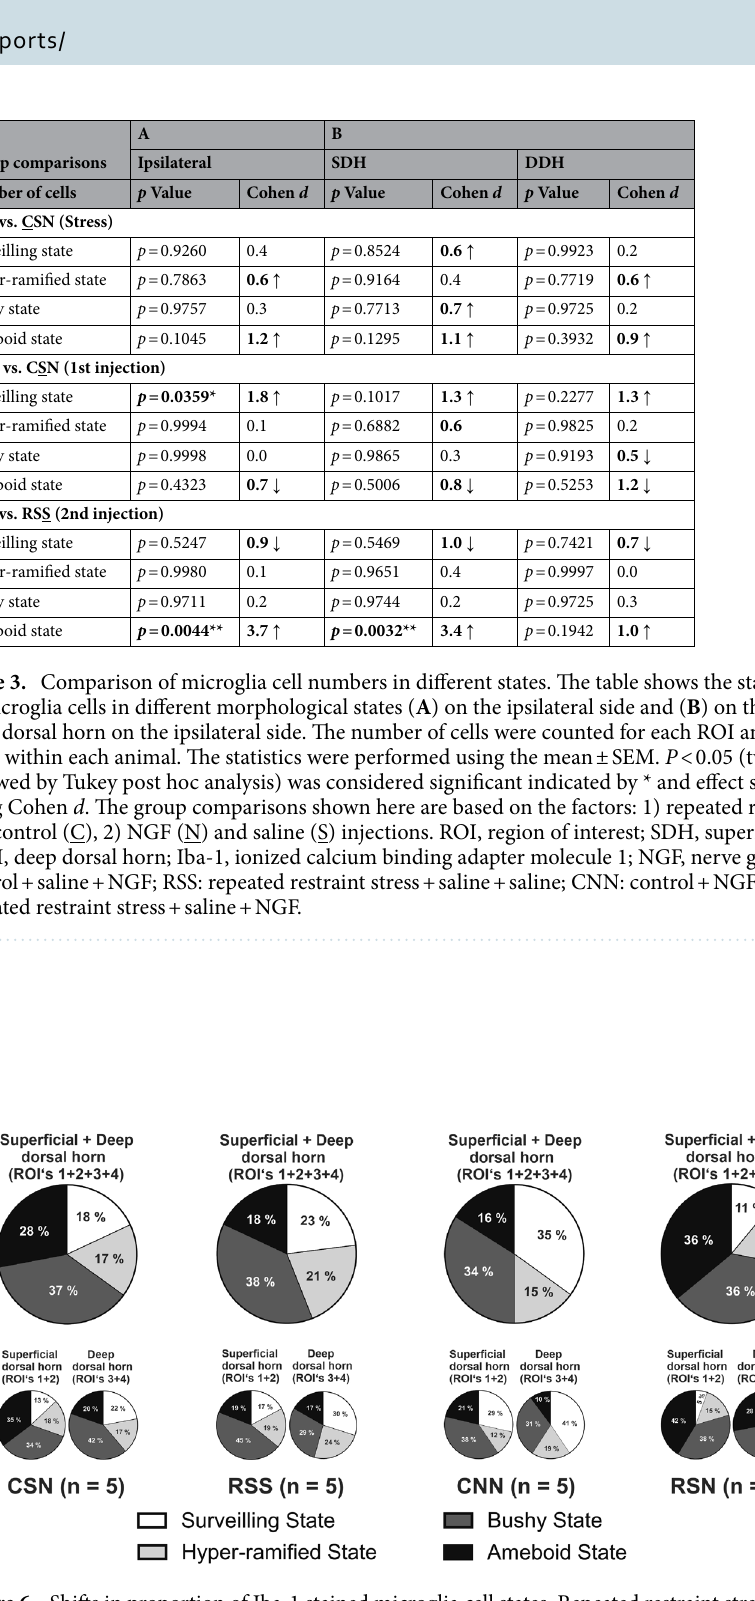
Figure 6. Shifts in proportion of Iba-1 stained microglia cell states. Repeated restraint stress in adolescence and intramuscular NGF in adulthood leads to increased ameboid state microglia cells in the ipsilateral superficial dorsal horn. ( A ) Pie charts illustrate the proportion of Iba-1 stained microglia cells in different states in each treatment group on the ipsilateral (ROI’s 1 + 2 + 3 + 4) dorsal horn. ( B ) Pie charts illustrate the proportion of Iba-1 stained microglia cells in different states in each treatment group on the superficial (ROI’s 1 + 2) and deep (ROI’s 3 + 4) dorsal horn. ROI, region of interest; NGF, nerve growth factor. CSN: control + saline + NGF (721 cells); RSS: repeated restraint stress + saline + saline (707 cells); CNN: control + NGF + NGF (806 cells); and RSN: repeated restraint stress + saline + NGF (886 cells). White: surveilling state; Light grey: hyper-ramified state; Dark grey: bushy state; and Black: ameboid